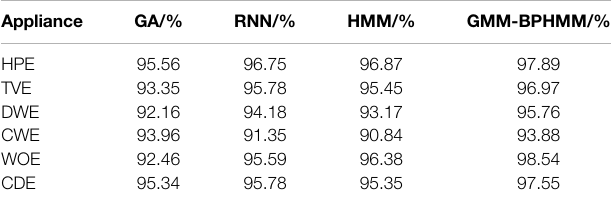
TABLE 2 | Comparison of average accuracy of state